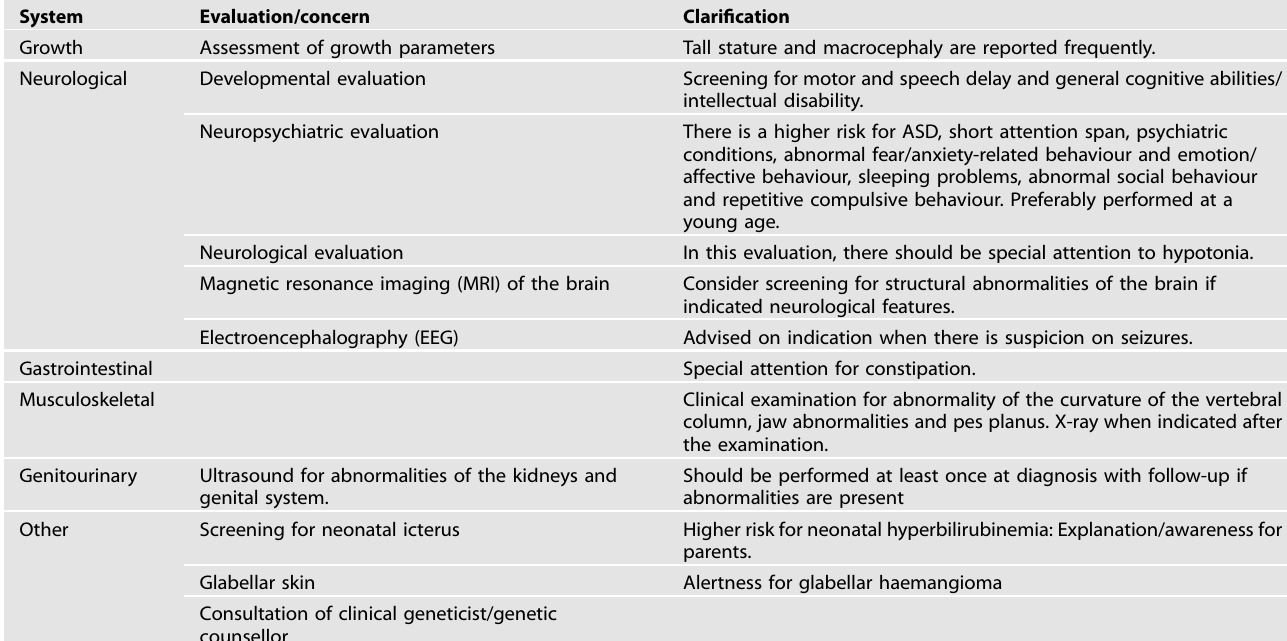
Table 3. Recommendations regarding follow-up and examination of individuals with a variant in CHD8 . System Evaluation/concern Clari fi cation Growth Assessment of growth parameters